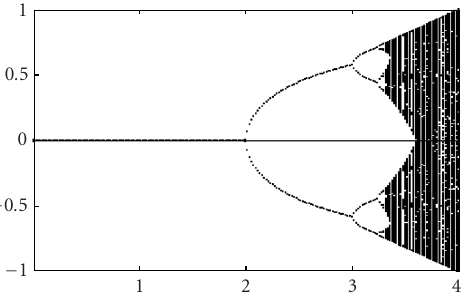
Figure 3.2. The complete bifurcation diagram of the iterated map Z n +1 = aZ 3 n +(1 − a ) Z n over 0 < a < 4 obtained using Z 0 = Z + and Z −